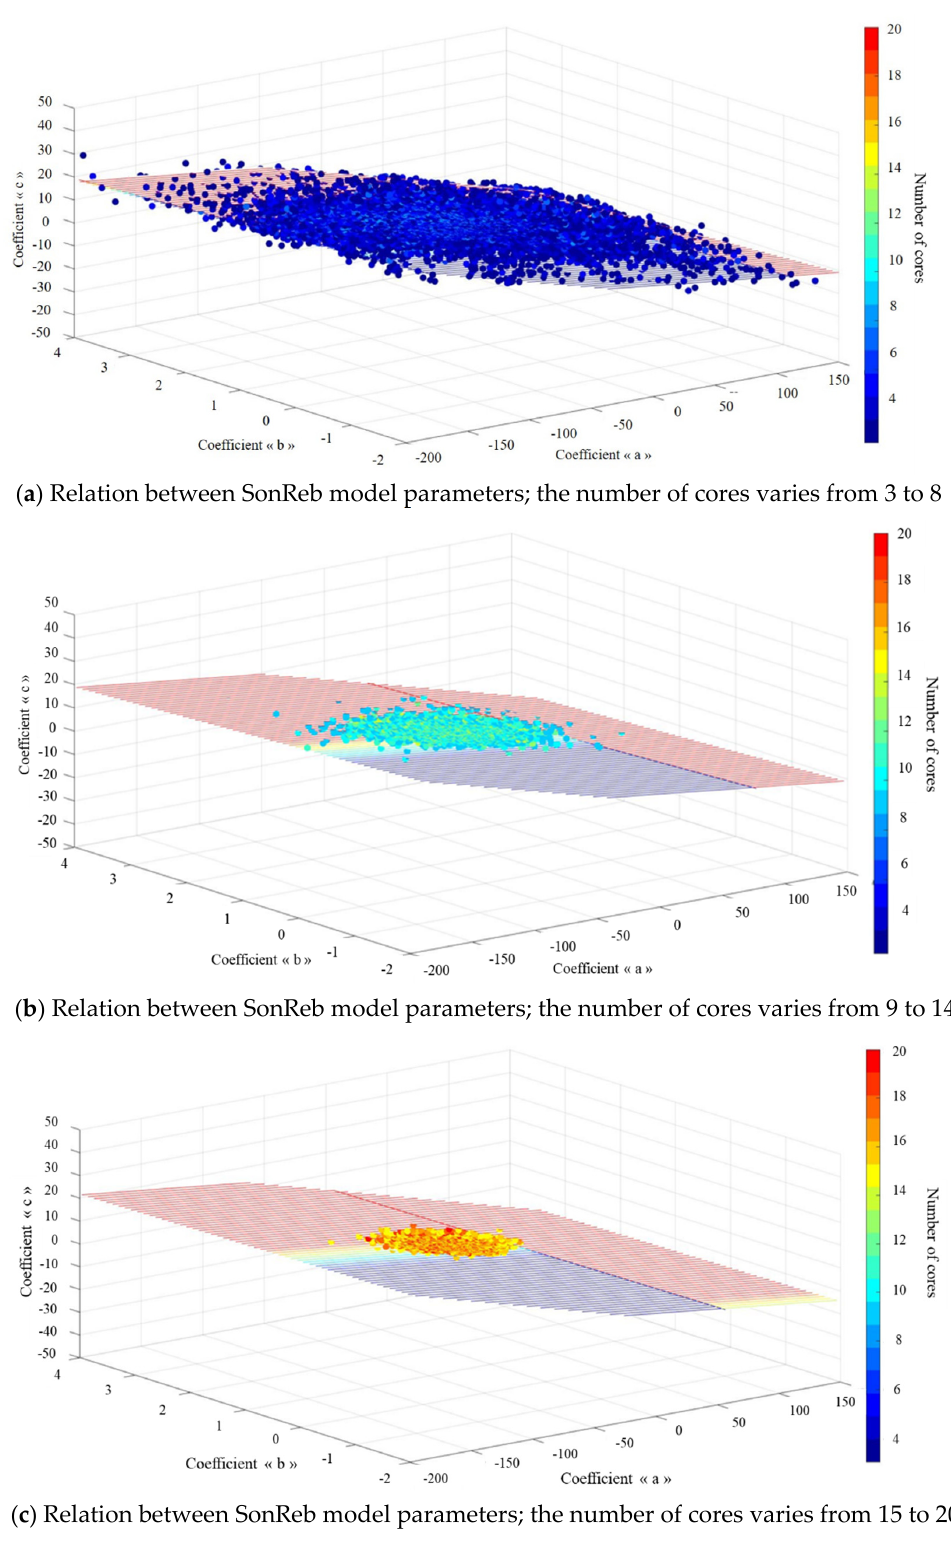
Figure 6. Effect of the trade-off as a function of the NC number.